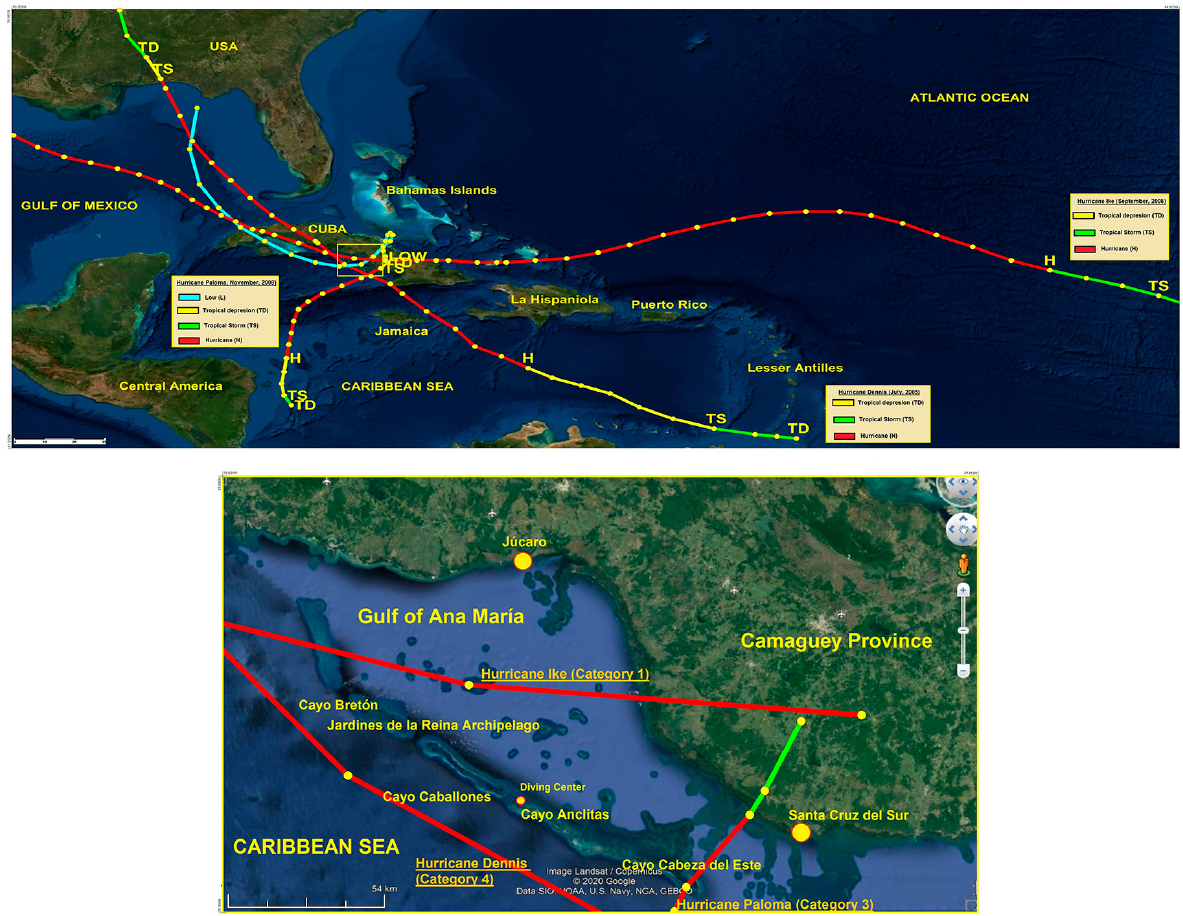
Fig. 2. – Hurricanes that affected the JRNP from 2000 to